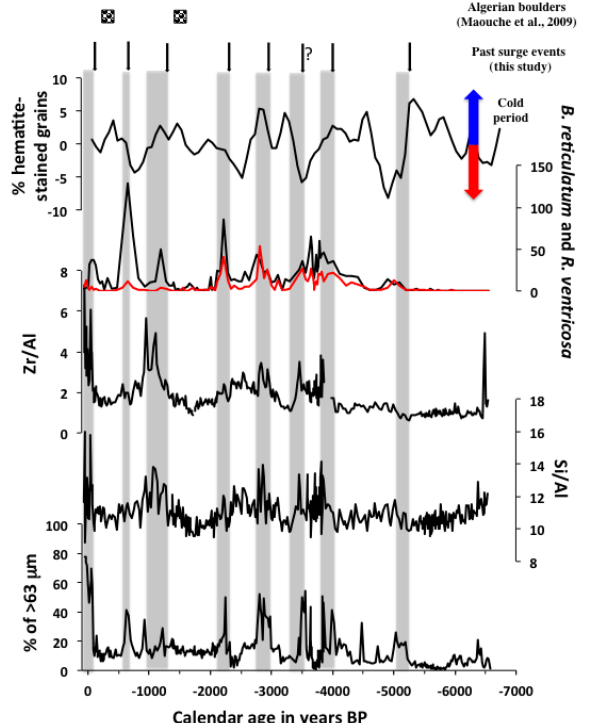
Figure 8. Core MM2 with from bottom to top: grain size (sand fraction); Si / Al and Zr / Al XRF ratio; number of B. reticulatum (black line) and R. ventricosa (red line); percentage of hematite- stained grains (Bond et al., 1997, 2001), ages of Algerian boulders (Maouche et al., 2009). Grey bands are the past surge